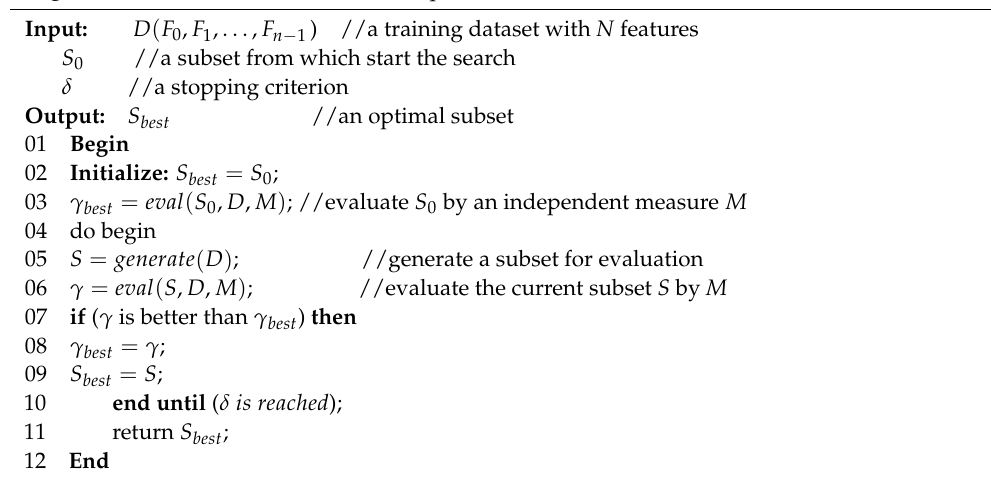
Algorithm 1: General filter-based